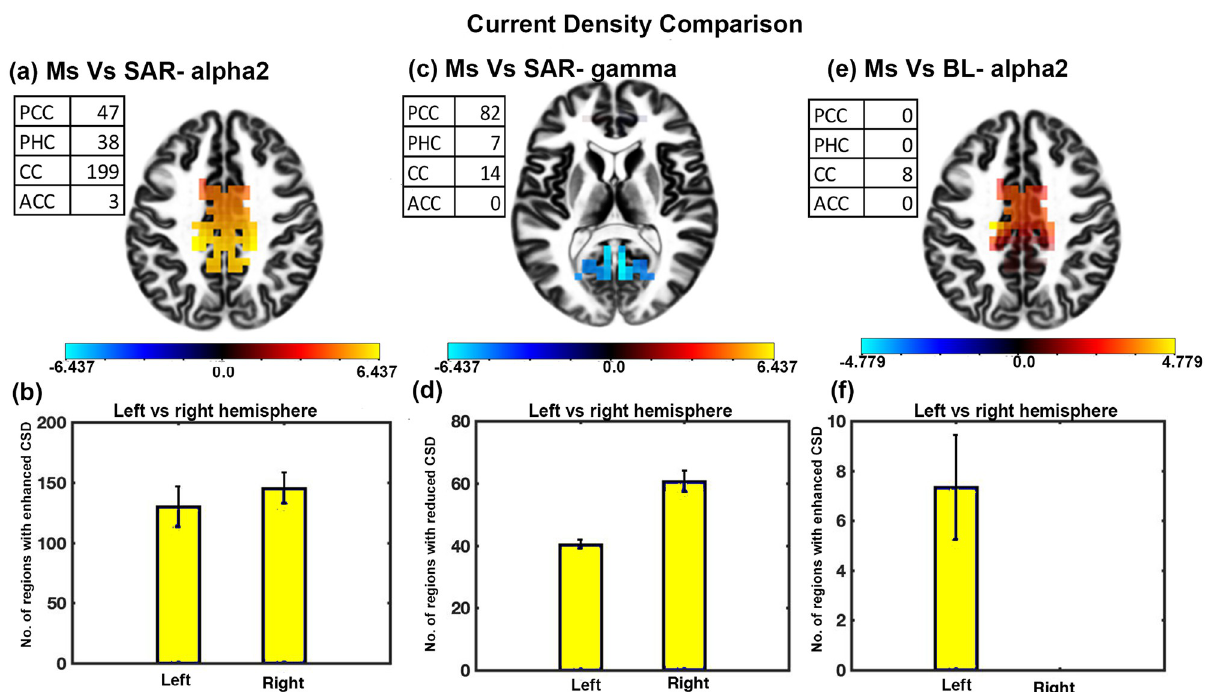
Fig 3. CSD analysis for sad music with SAR condition and baseline. (a) Slice frontal view representation of the brain regions depicting the change in the CSD in the alpha2 band (b) The hemispheric difference concerning the number of brain regions having significantly enhanced CSD during sad music intervention compared to SAR state. (c) Slice frontal view representation of the brain regions depicting the change in the CSD in the gamma band (d) Brain hemisphere lateralization with respect to the number of regions with decreased CSD in the gamma band (e) The Slice frontal view representation of the brain regions depicting the change in the CSD in the alpha2 band for sad music listening compared to baseline (f) Brain hemisphere lateralization with respect to the number of regions with increase CSD in alpha2 band (error bars = 1 SD).